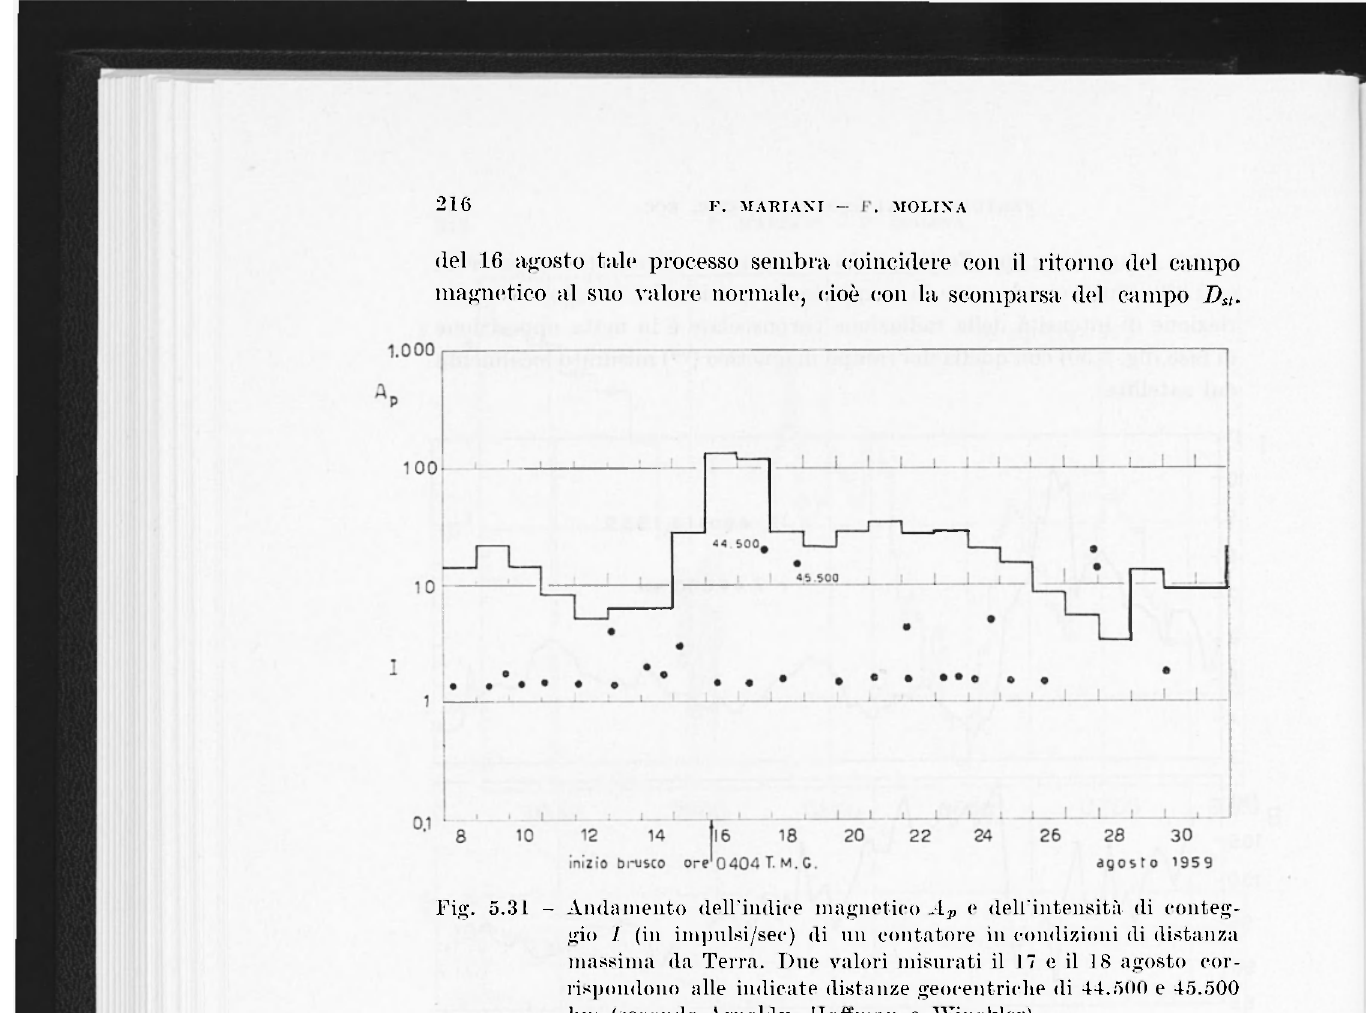
Fig. 5.31 - Andamento dell'indice magnetico A p e dell'intensità di conteg- gio / (in impulsi/sec) di un contatore in condizioni (li distanza massima da Terra. Due valori misurati il I 7 e il 18 agosto cor- rispondono alle indicate distanze geocentriche di 44.500 e 45.500 km (secondo Arnoldy, Hoffman e